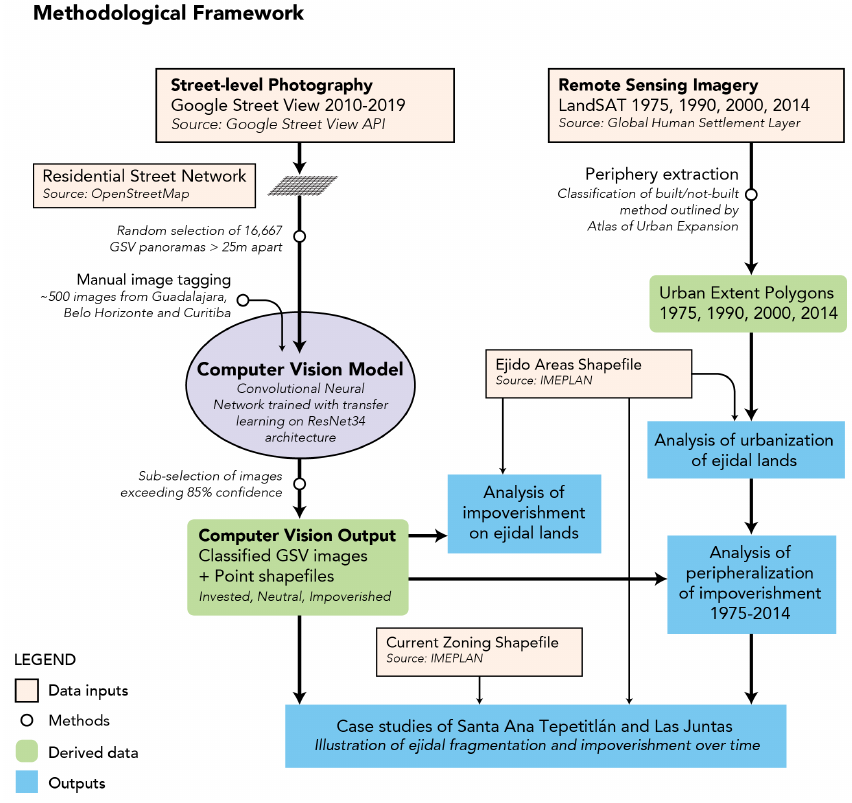
Figure 3. Summary of methodological